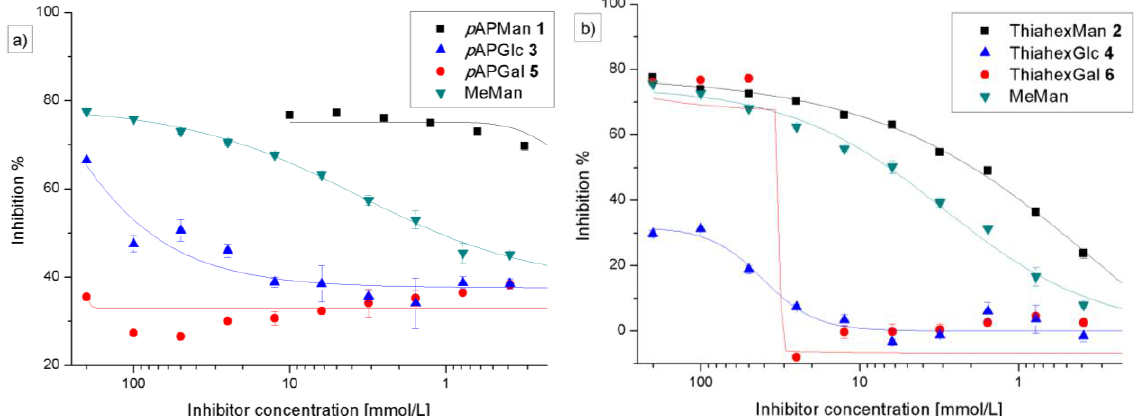
Figure 6. Preincubation-inhibition-adhesion assay with GFP-tagged E. coli : Inhibition of bacterial adhesion to mannan as obtained with the phenyl glycosides 1 , 3 , and 5 ( a ) and the alkyl glycosides 2 , 4 , and 6 ( b ) after preincubation with the bacteria. The depicted inhibition curves are representative examples from several (>3x) independent experiments. The standard inhibitor, MeMan, was tested on the same plate. Error bars result from duplicate values on one